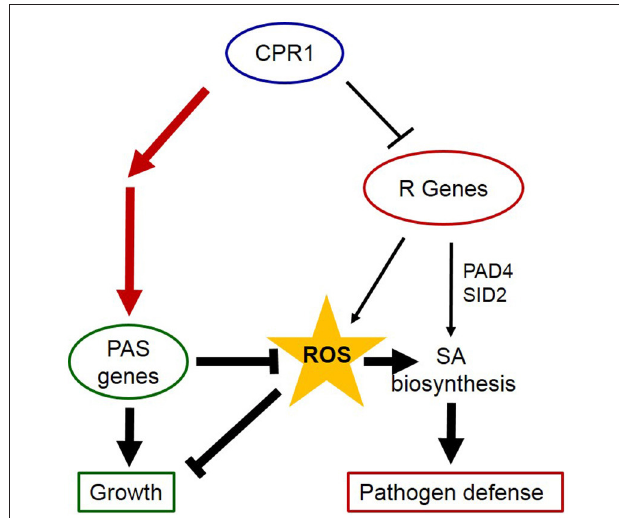
FIGURE 12 | CPR1 supports growth and avoids activation of pathogen responses via regulation of PAS gens. CPR1 antagonizes activation of ETI in absence of pathogens by marking R-genes for degradation (thin lines). Via their impact on the cellular ROS levels, PAS enzymes impact on SA-biosynthesis and induction of ETI (bold lines). Here, we showed that CPR1 is essential for full induction of PAS genes and that CPR1-controlled PAS regulation is independent of SA accumulation (red lines). We conclude that CPR1 controls two interacting signaling pathways, in which full expression of PAS genes antagonizes accumulation of ROS, which are signals activating biotic and abiotic stress responses. The chloroplast loop is supposed to help wildtype plants to avoid activation of cost-intensive and growth limiting defense reactions in absence of biotic and abiotic